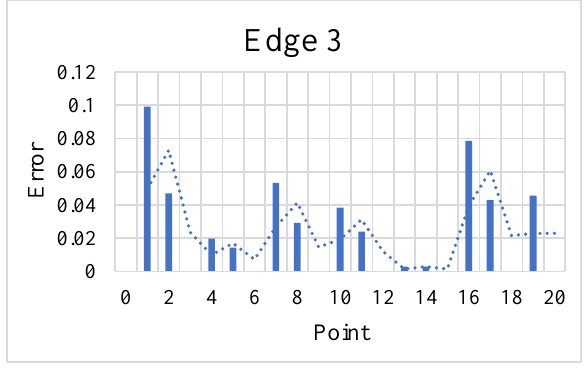
Graph 1. Deviations of grid points from the nominal for a result of 3.